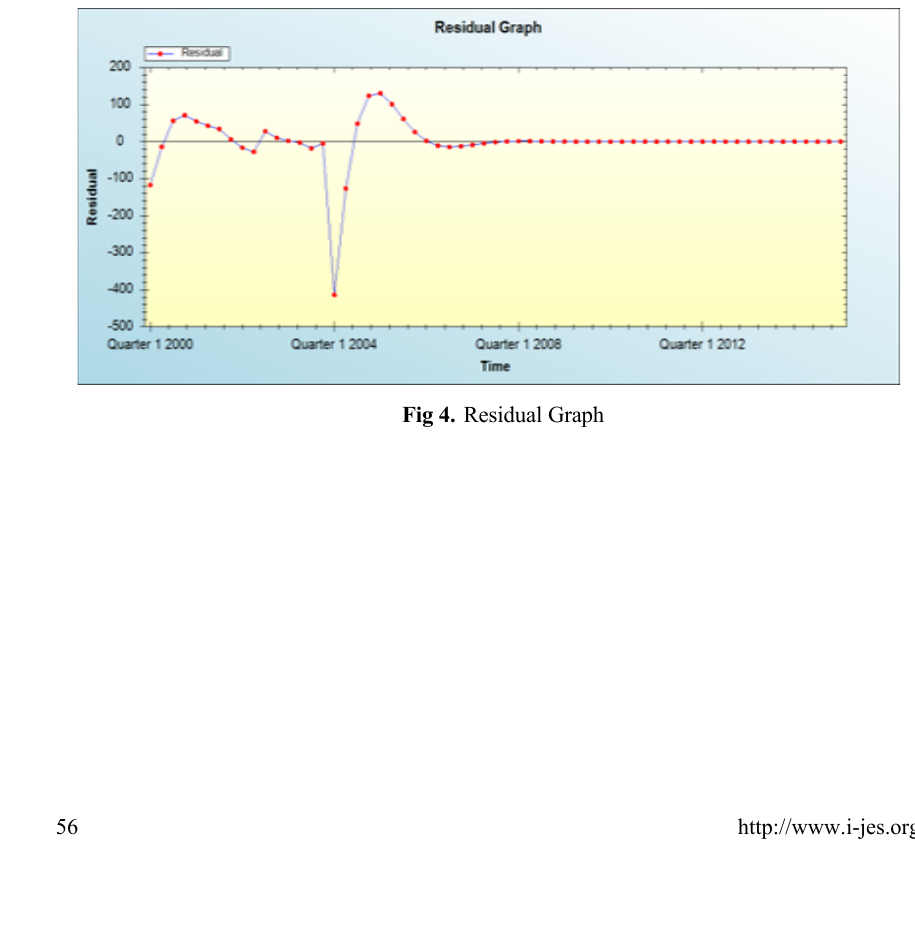
Actual and Predicate Graph